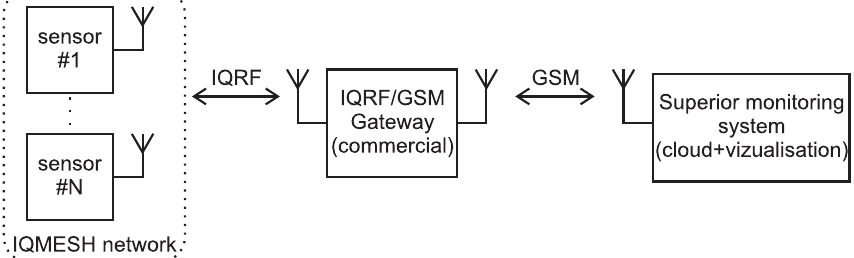
Figure 1. Block scheme of the monitoring system measurement